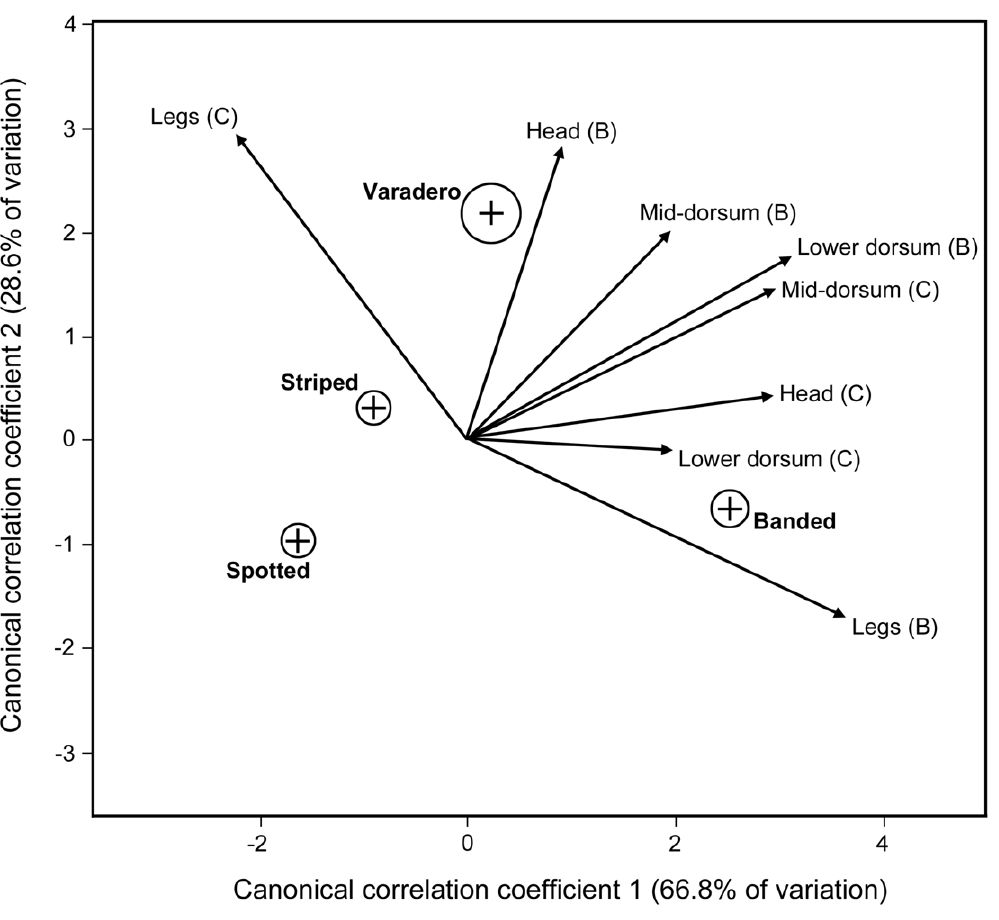
Figure 3. Canonical Space for R. imitator morphs using an avian visual model for frog contrast estimates against a green background ( Heliconius leaf). Crosses represent the average canonical scores and the circles represent the 95% confidence ellipses for the four R. imitator morphs. The multivariate linear model included avian model estimates for brightness (B) and color contrast (C) of four body region reflectances (head, mid and lower dorsum, legs).